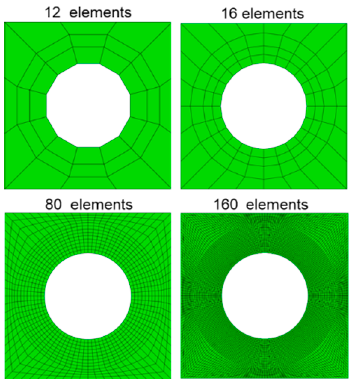
Figure A2. Details of the mesh refinements around the hole in the unidirectional OHC coupon 2D FE mesh for a circumferential mesh density of 12, 16, 80 and 160 elements.